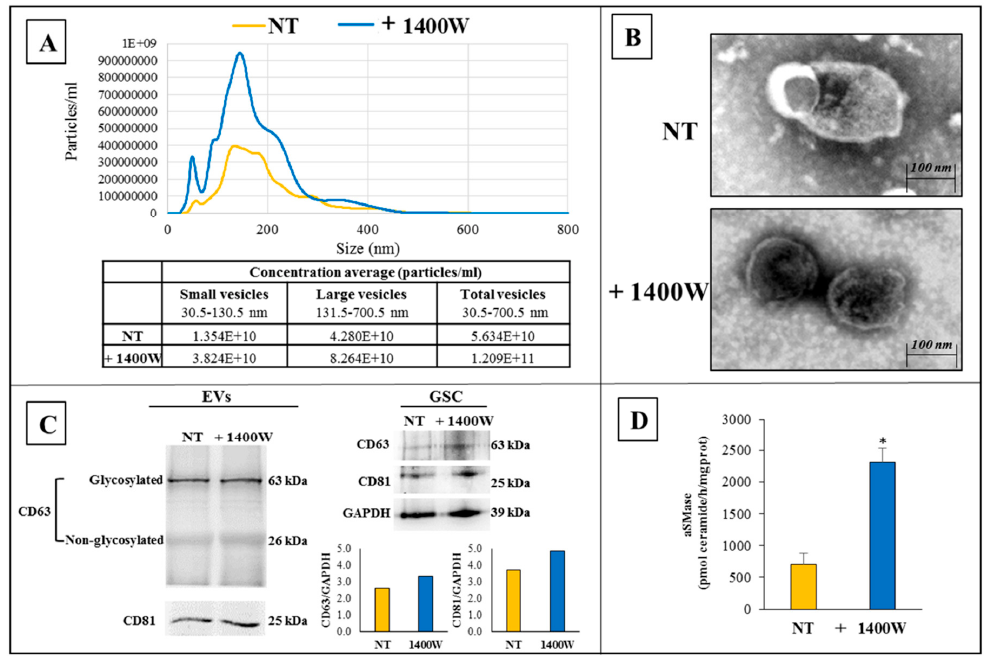
Figure 5. Characterization of extracellular vesicles (EVs) released by U87MG-derived NS after 48 h incubation without or with 1400W. ( A ) Size distribution of EVs from U87MG-derived NS by Nanoparticles Tracking Analysis (NTA). Concentration average of particles per ml is reported in the table. ( B ) Morphological analysis of EVs from U87MG-derived NS, treated or not with 1400W (100 µ M) for 48 h, was evaluated using transmission electron microscopy (TEM) (scale bar 100 nm). Pictures show membrane bound vesicles with a spheroid shape. ( C ) Representative western blots of EVs